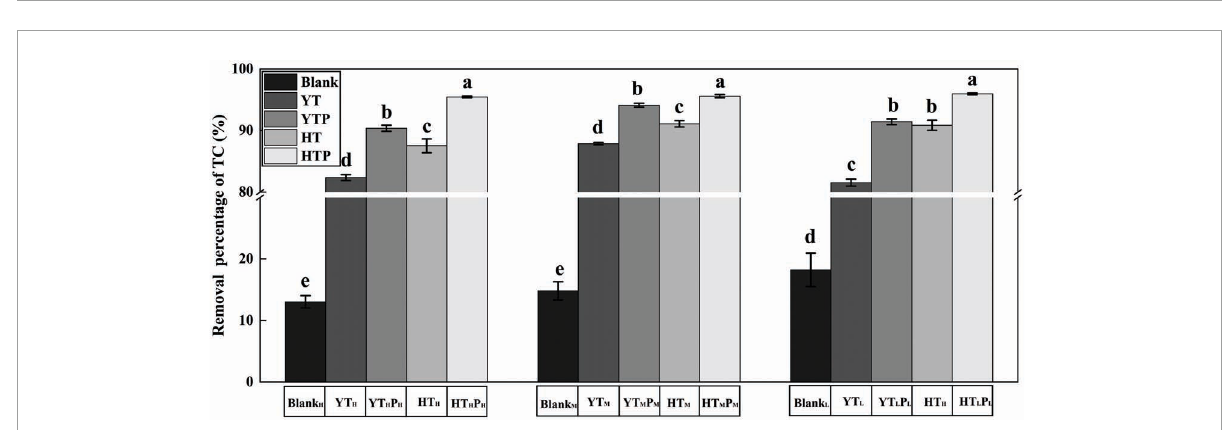
FIGURE3 Removal percentage of TC residues from various treated sediments. Blank H , Blank M , and Blank L refer to 180, 120, and 60 mg · L - 1 TC solution after stored for 30 days, respectively. HT, HTP refer to the riverbed sediment treated by TC and TC/g-C 3 N 4 for 30 days, respectively. YT, YTP refer to the pig farm sediment treated by TC and TC/g-C 3 N 4 for 30 days, respectively. The error bars represent the SDs ( n = 3). Significant differences were determined by Duncan’s test There were significant differences between different letters (a, b, c, d, e) ( p <